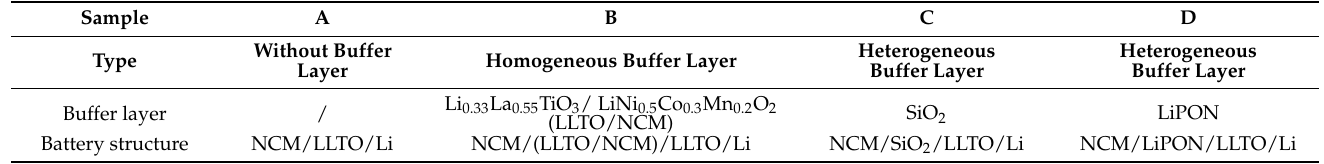
Table 1. Sample classification and the corresponding buffer